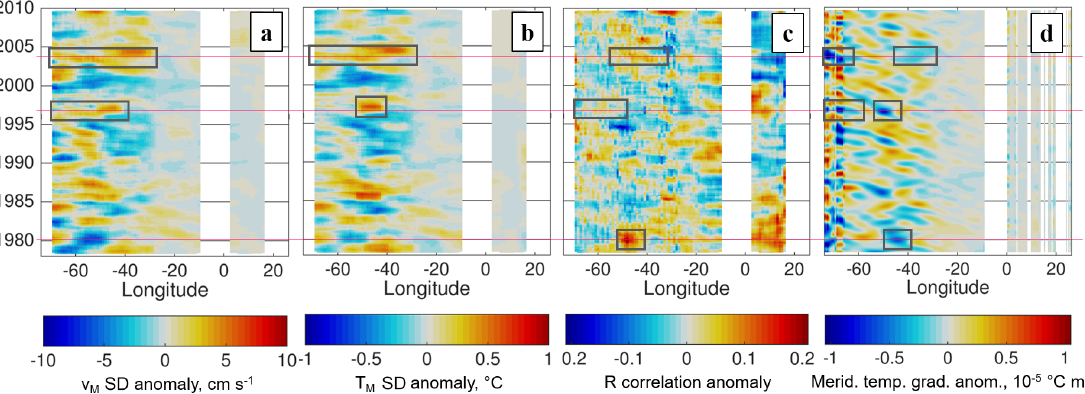
Figure 12. Same as Fig. 11 but with the time means removed. Anomalies associated with high MTF events in 1980, 1996, and 2003 are indicated by gray